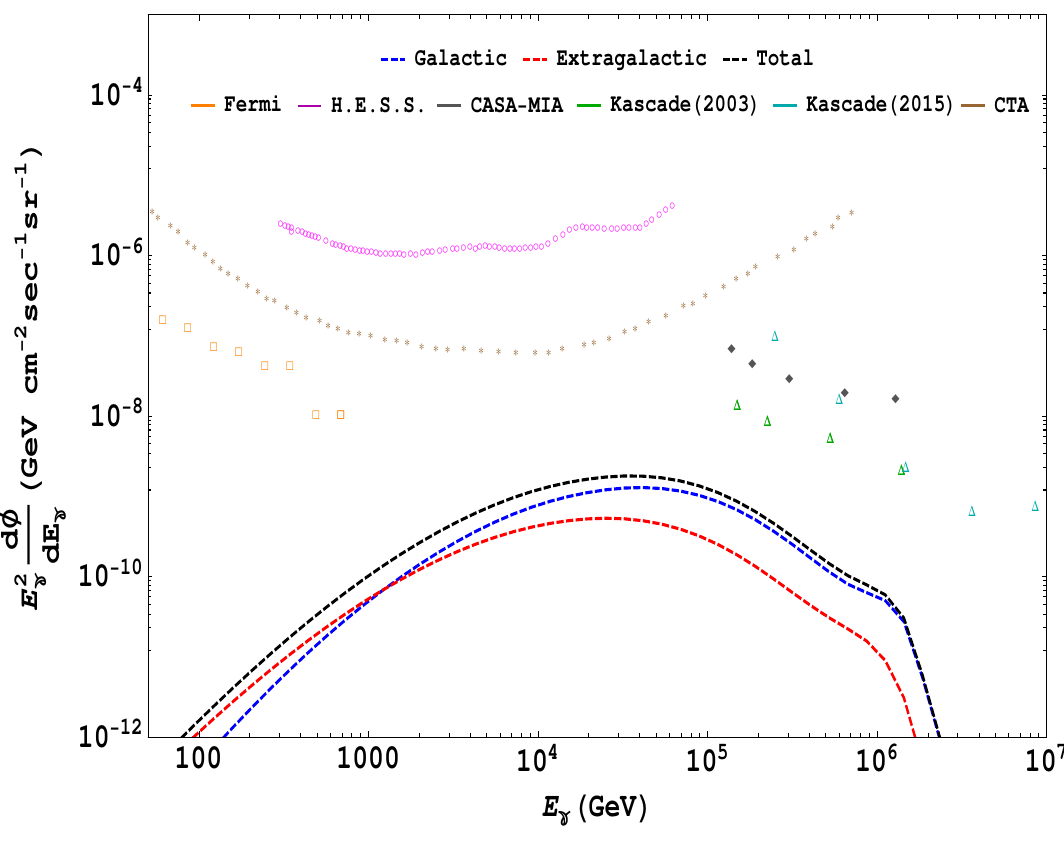
Figure 6 . The predicted terrestrial gamma-ray (cid:13)ux from the RH sneutrino decay ~ N 1 ! where the decays of the Higgs give rise to gamma-rays. We have not accounted for secondary gamma-rays here. We have used the benchmark value m ~ The current constraints on the di(cid:11)use gamma-ray (cid:13)ux from Fermi-LAT, H.E.S.S., CASA-MIA and KASCADE data are shown, and our predicted (cid:13)ux is well below limits set by these experiments. We have also shown the expected di(cid:11)use (cid:13)ux sensitivity of CTA with 500 hours of observation, and we can see that our predicted (cid:13)ux is unfortunately below CTA’s